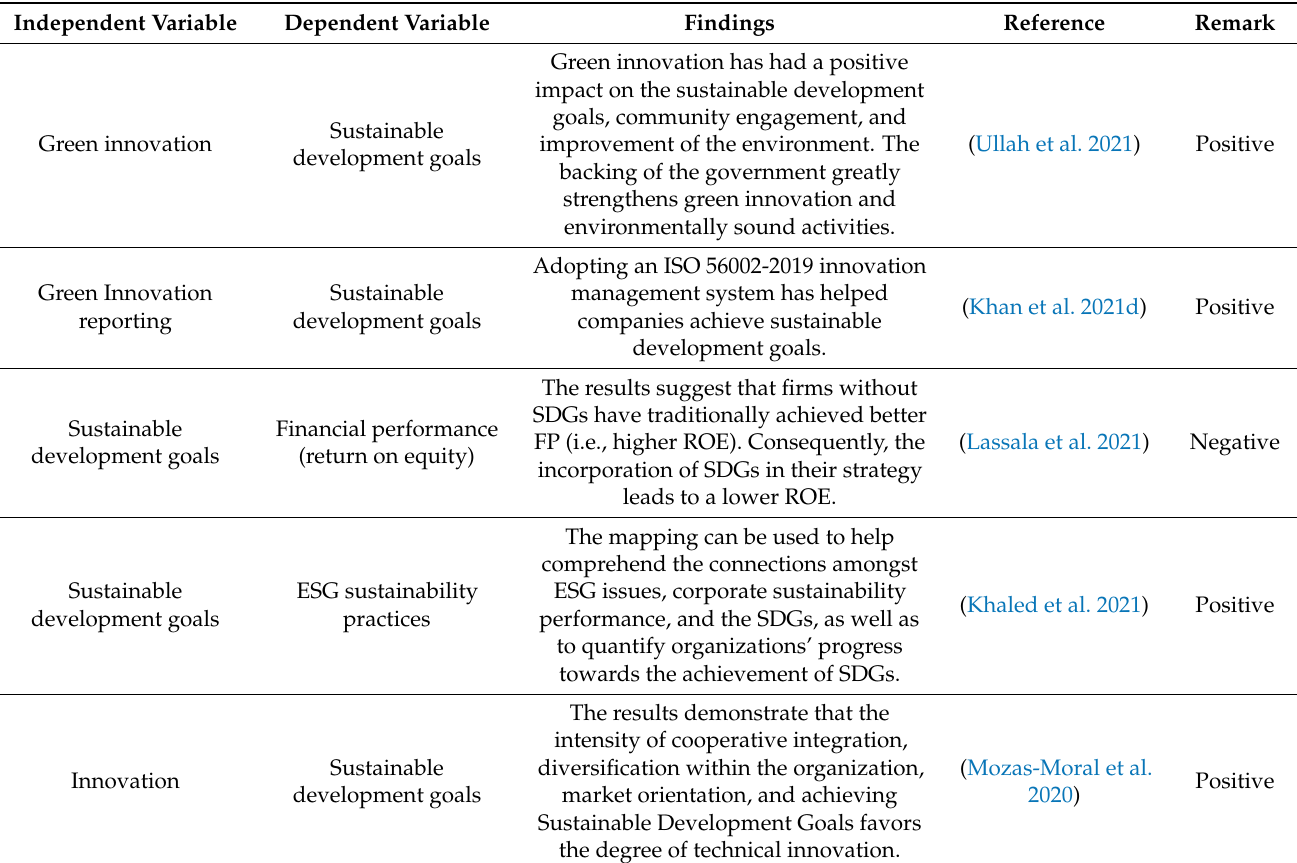
Table 1. Related Literature—Identifying Research